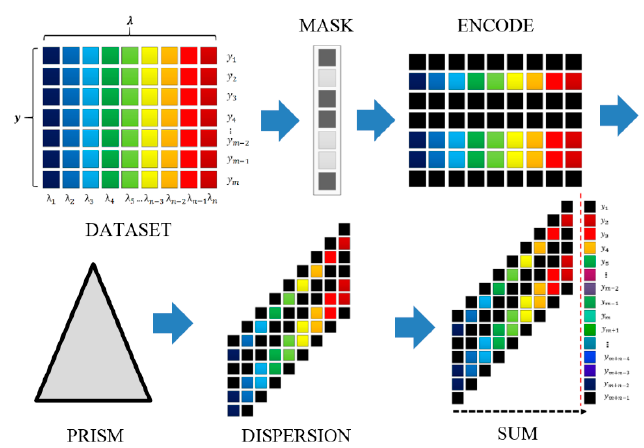
Figure 1. Schematic of Coded Aperture Snapshot Spectral Imaging (CASSI) showing three stages in the “Mask-Prism” model: The original multispectral data are encoded by an array of coded aperture mask, the encoded dataset is sheared by the prism, and eventually the spatial–spectral data is integrated at the detector in a multiplex manner.